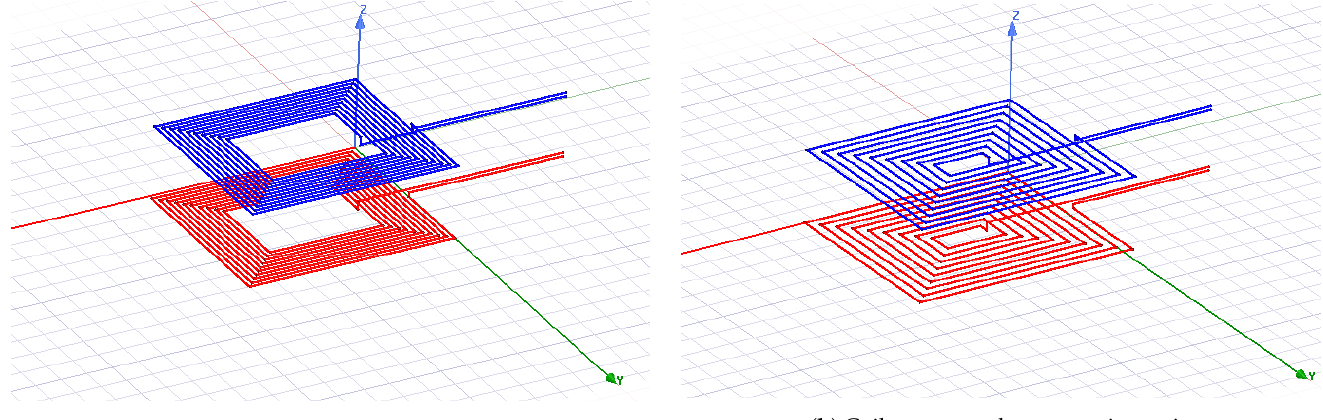
Figure 8. Coil geometry of various covering ratios.